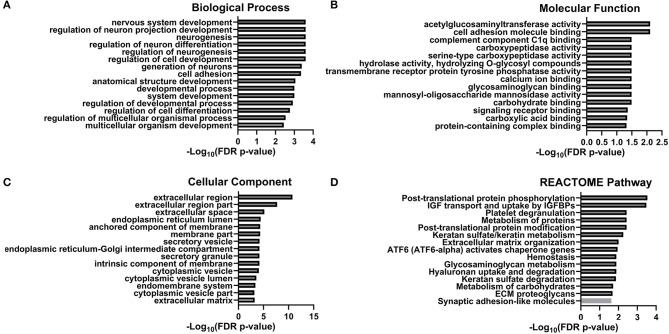
GO/KEGG column graph. The top 15 enriched items of the enrichment analysis including three GO categories [Biological Process (A), Molecular Function (B), and Cellular Component (C)] and regulative pathway [REACTOME Pathway (D)].